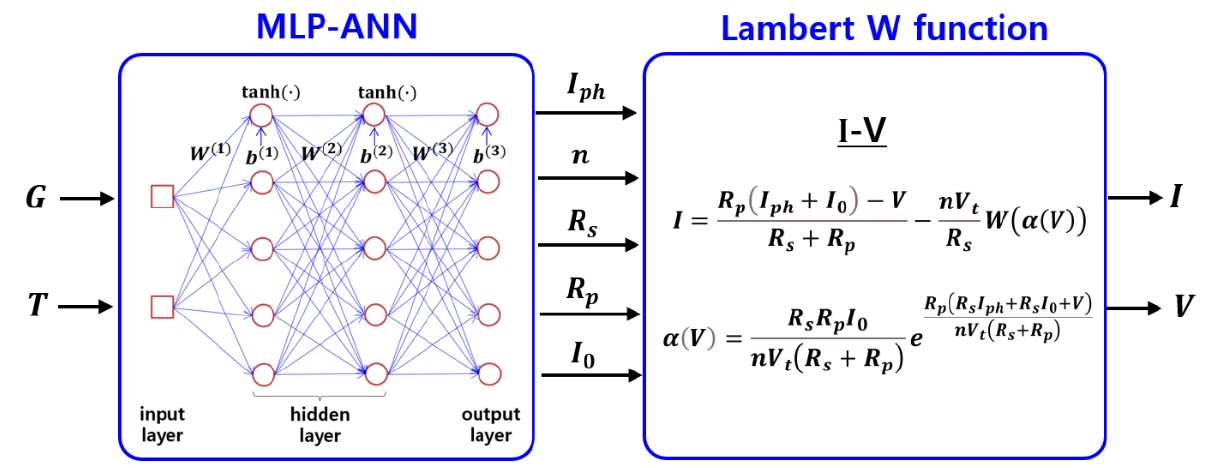
Figure 2. Configuration of the proposed photovoltaic model.